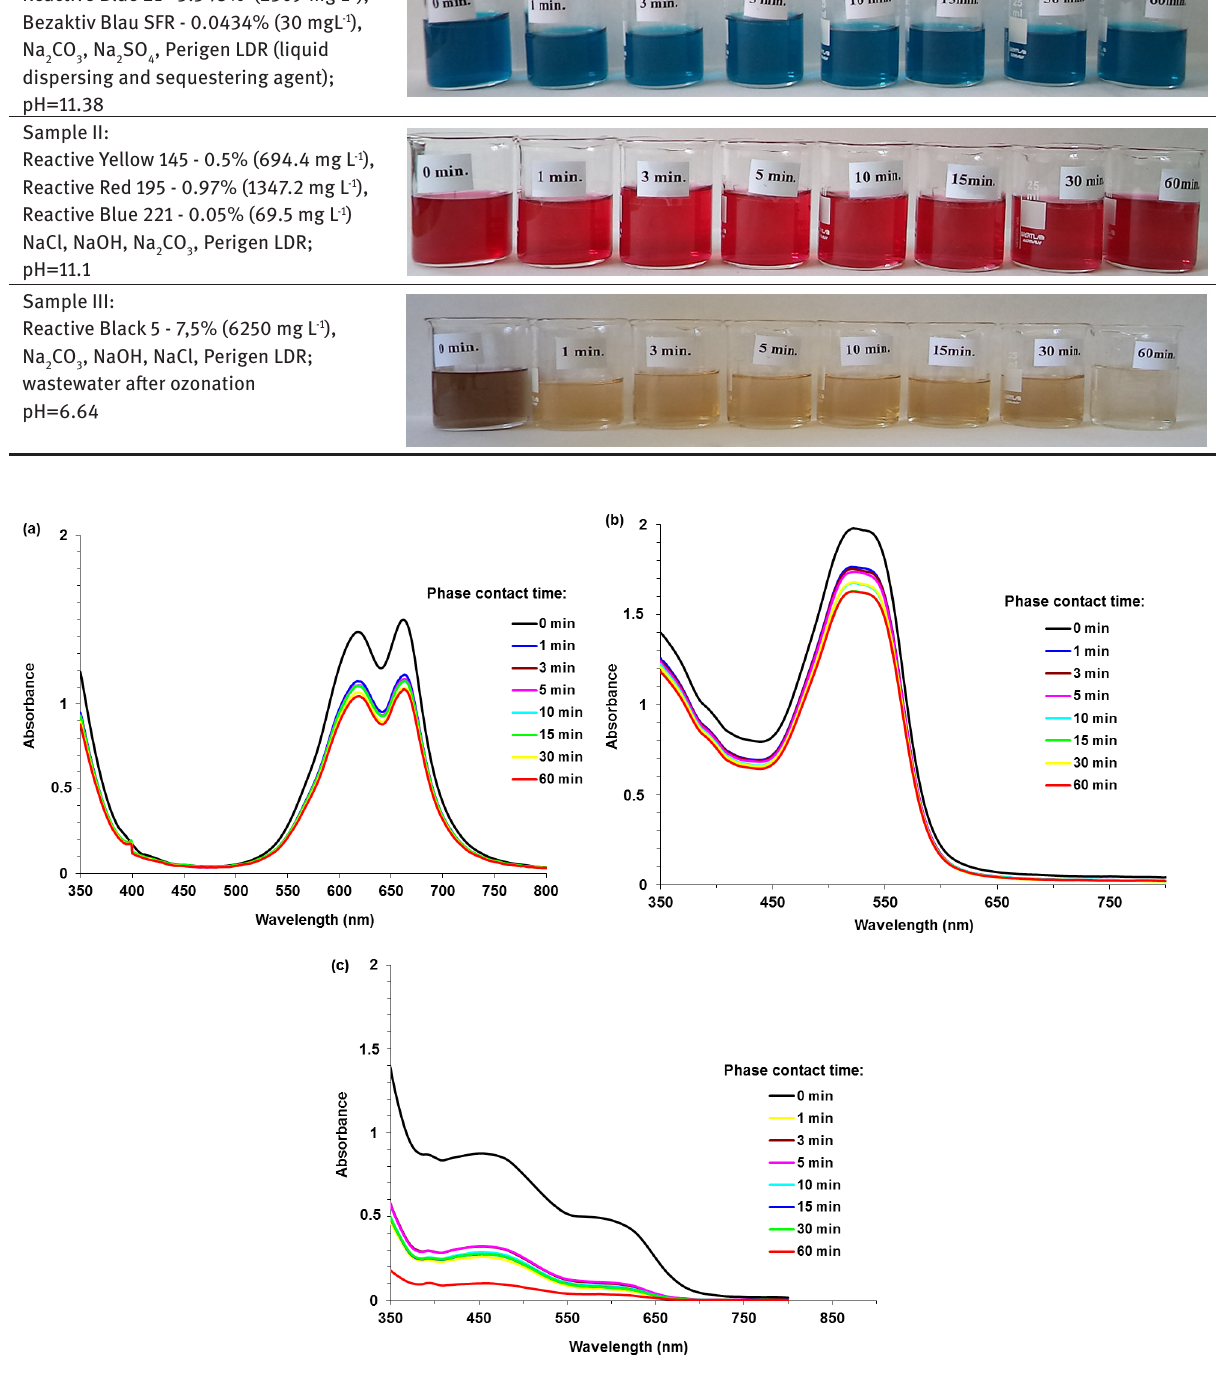
Figure 3. Absorbance spectra of acid raw wastewaters purified by means of the aminosilane modified silica ( conditions: wastewaters composition (see Table 3): (a) sample I, (b) sample II, (c) sample III, volume: 50 mL, sorbent mass: 0.5 g, agitation speed: 180 rpm, temperature: 25 o C, phase contact time: 1-60